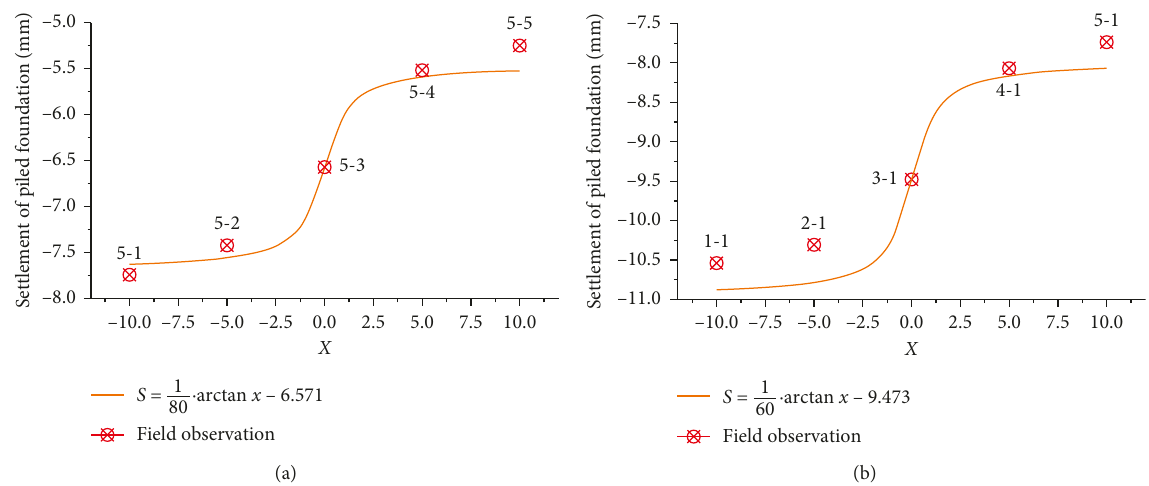
Figure 22: Calculation results and settlement of piled foundation: (a) calculation results and field observation of 5-1 ∼ 5-5; (b) calculation results and field observation of 1-1 ∼